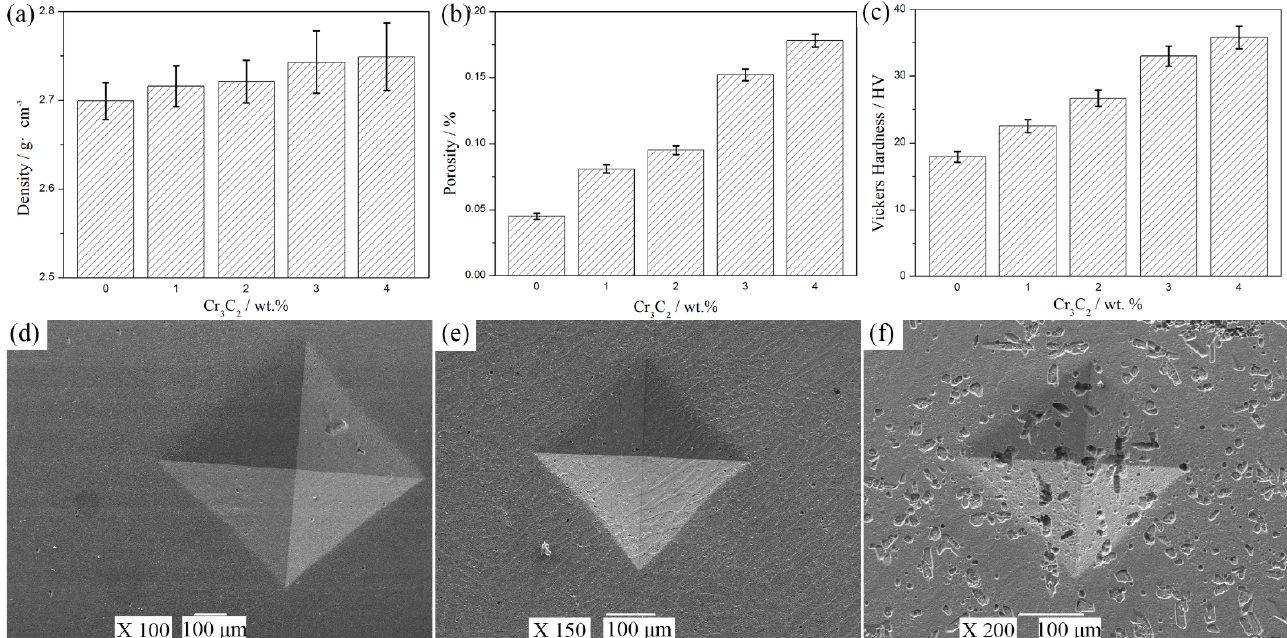
Figure 4. The element distributions of the 1.0 wt. % Cr 3 C 2p /Al composite sample: ( a ) microstructure, ( b ) Al element, ( c ) Cr element, and ( d ) C element.